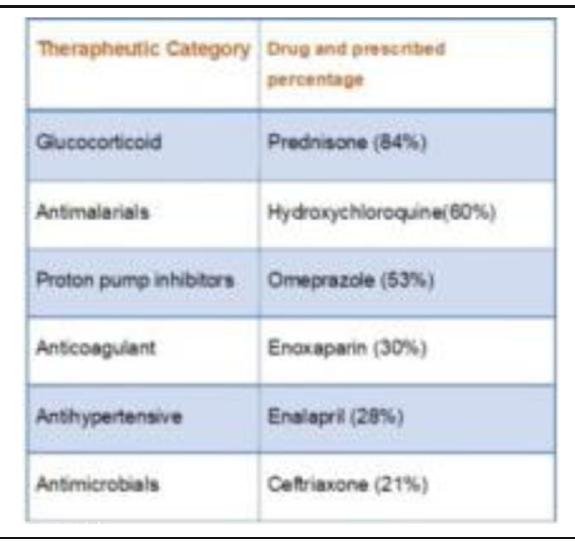
Table 2 (abstract P029). See text for